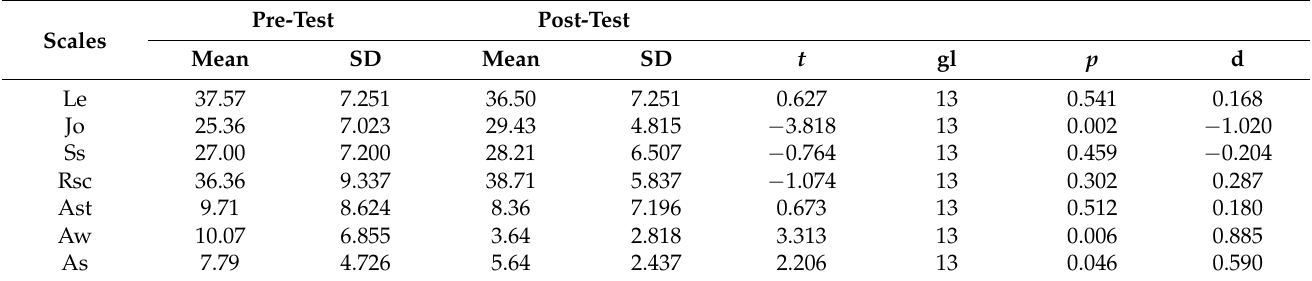
Table 7. Scores obtained in the parents’ BAS at the beginning and end of the fourth grade of primary school.